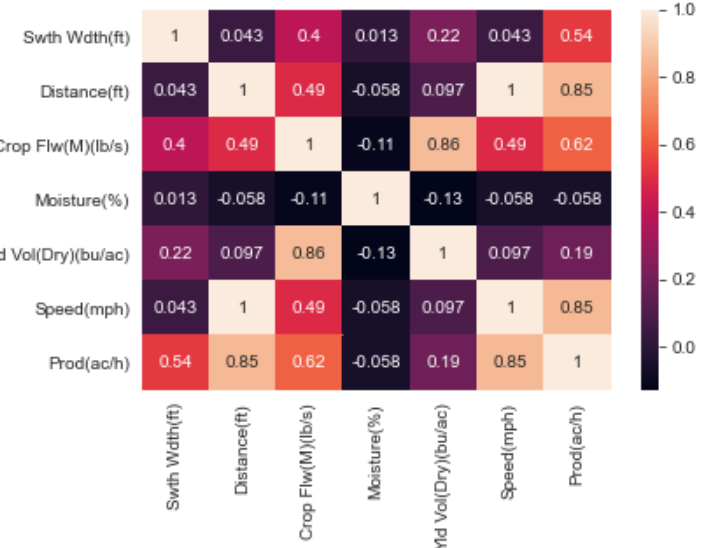
Figure 5. Correlation matrix heatmap for the data set.